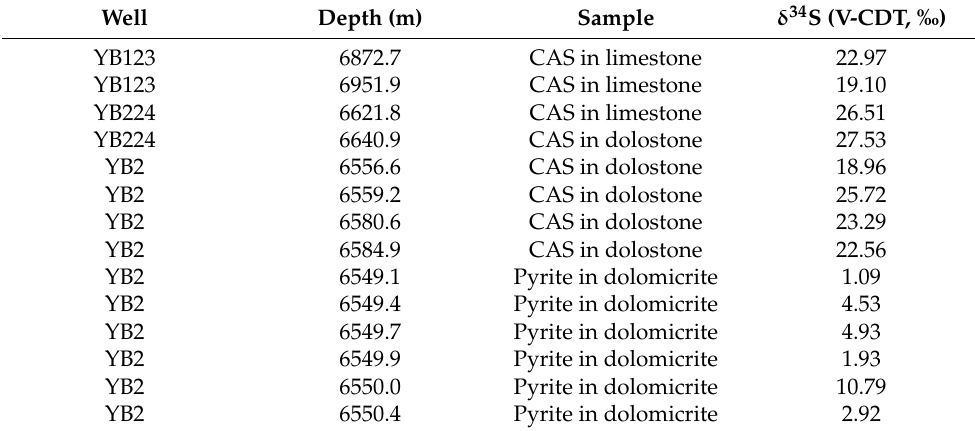
Table 2. δ 34 S values for carbonate-associated sulfates (CAS) and pyrites extracted from P 3 c carbonates in the YB gas